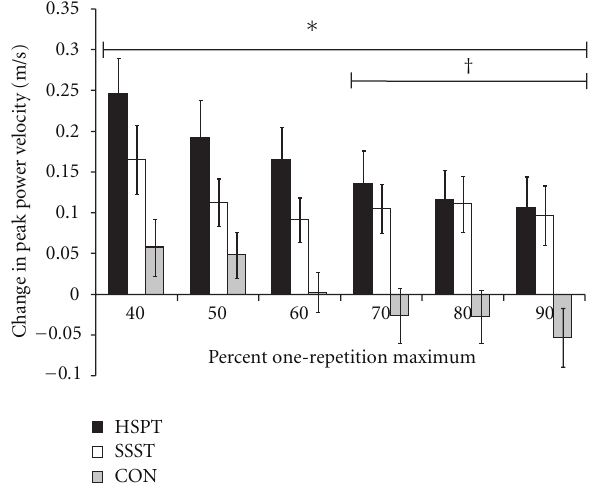
Figure 4: Baseline to posttraining changes in leg press peak power velocity relative to baseline one-repetition maximum (1RM) across a range of external resistances. HSPT = high-speed power training; SSST = slow-speed strength training; CON = control. ∗ HSPT > CON; † SSST >